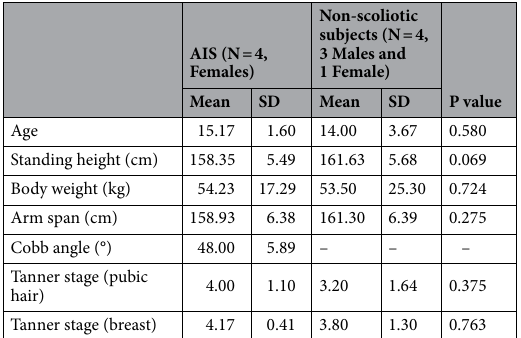
Table 1. Clinical and demographic characteristics of participants involved in discovery